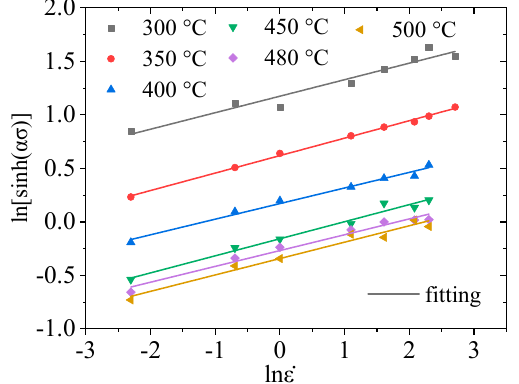
. ε . Figure 8. The relation curve of 𝑙𝑛 𝑠𝑖𝑛ℎ(cid:4666)𝛼𝜎(cid:4667) (cid:3398) 𝑙𝑛𝜀(cid:4662) .